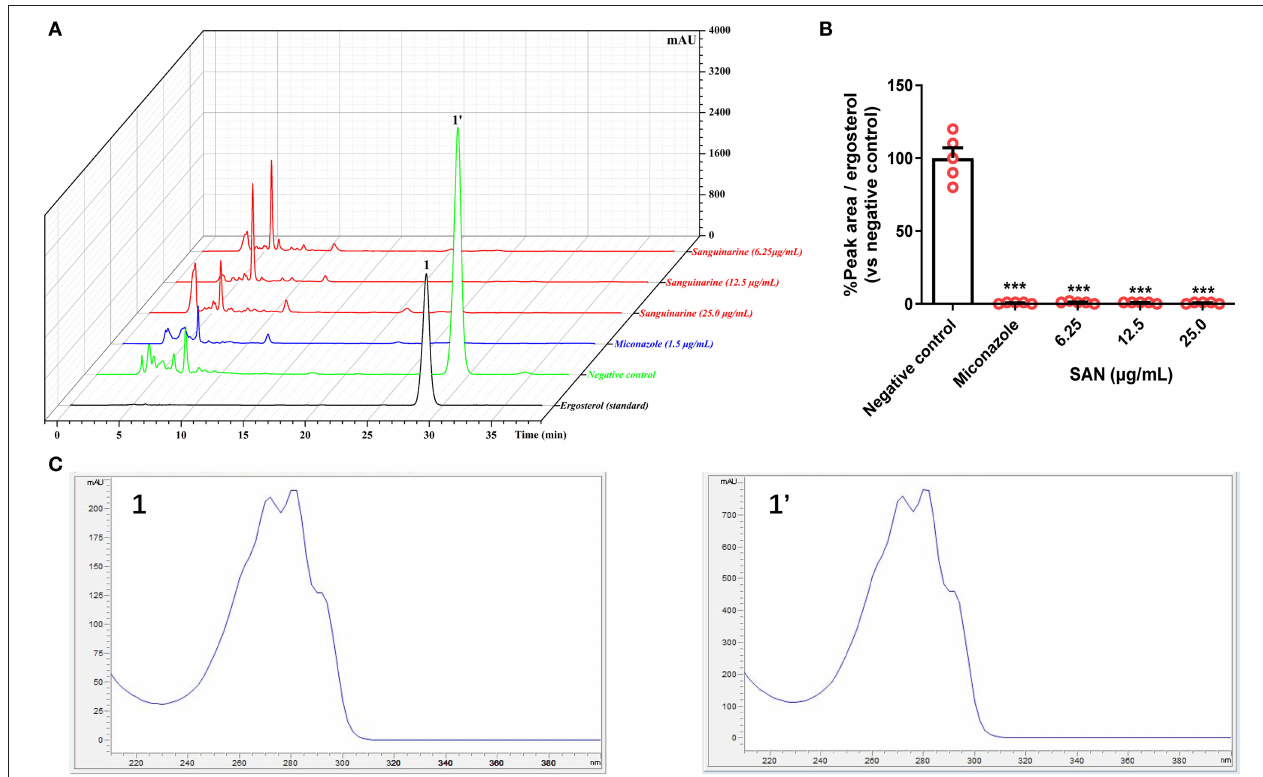
FIGURE 4 | (A) Superimposed HPLC-DAD chromatograms at 282nm of ergosterol extracted from C. albicans treated with miconazole (1.5 µ g/mL) and SAN (6.25, 12.5, and 25.0 µ g/mL). (B) Relative HPLC peak areas of ergosterol [Retention time (RT) = 28.7min]. (C) The comparison of UV Spectra data between the peak 1 (standard ergosterol) and 1’ at RT = 28.7min. The data are presented as the mean ± SEM ( n = 4, *** p < 0.001 compared to negative control, ANOVA).